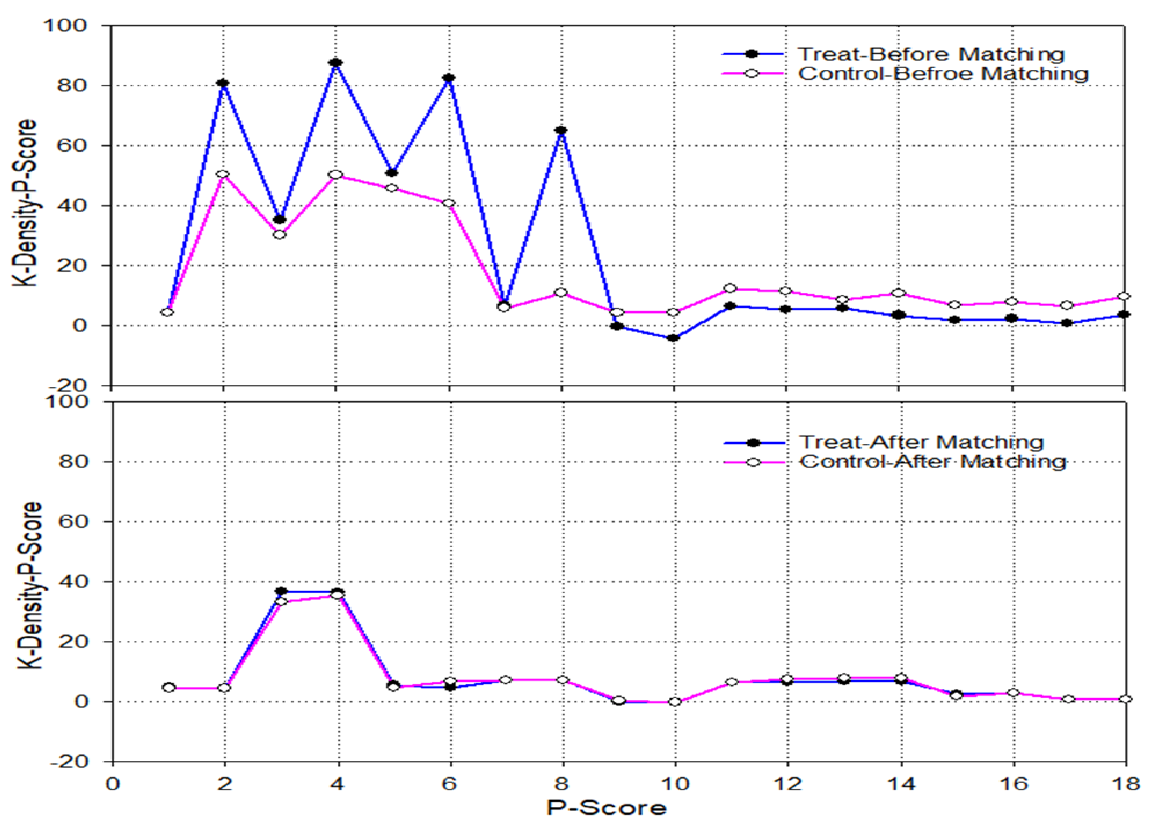
Figure 4. PSM distribution of treatment and control groups. The empirical findings of PSM-DID methods are presented in Table 6, assessed us- ing Equation (6). The terms interaction coefficients Treat × T, Treat × year2012, and Treat × year2013 are still significant and with negative coefficients, consistent with the outcomes presented in Table 4 , which indicates that the mobile phone promotion policy reduced the IF usage. This result is consistent with the findings of Zhao et al. [47] which indicates that farmers who can effectively use IT resources have stronger production safety capabilities and are more likely to reduce the IF used. Therefore, in addition to the shallow IT use, the in-depth use of this modern technology may also be an important factor affecting farmers to reduce